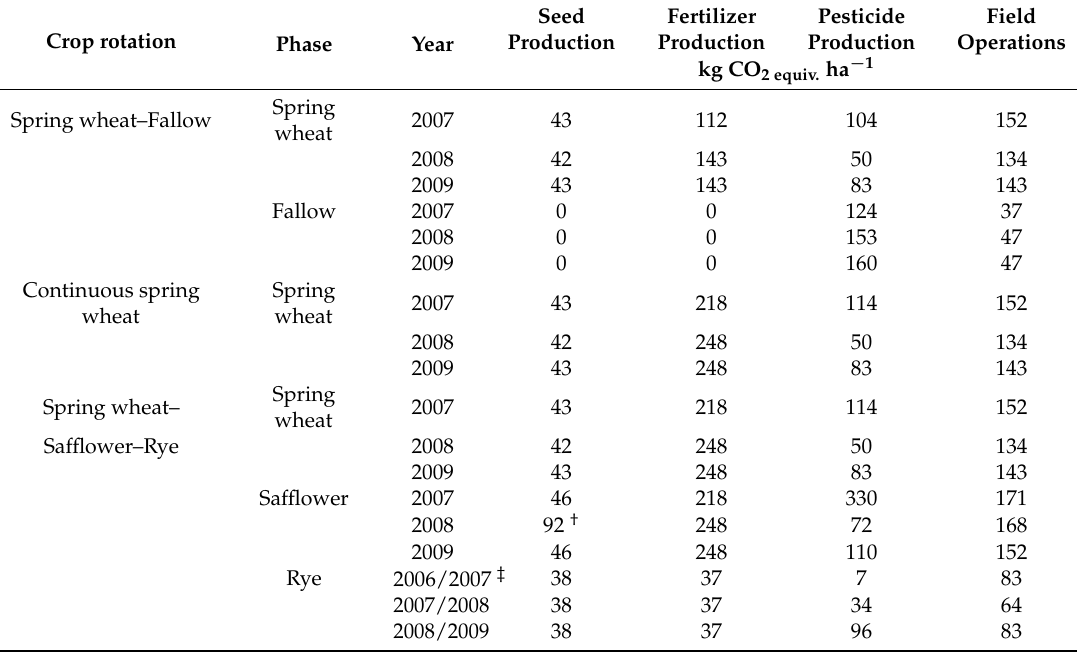
Table 2. Carbon dioxide emissions associated with production inputs and field operations for cropping systems evaluated in study. Values derived from Lal (2004), Özilgen and Sorgüven (2011) and West and Marland (2002).